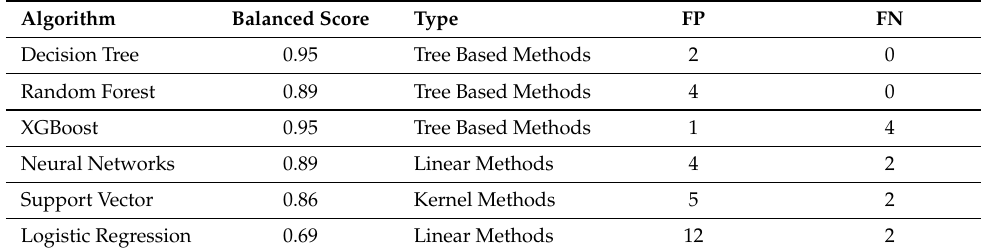
Table 2. Balanced Accuracy Result